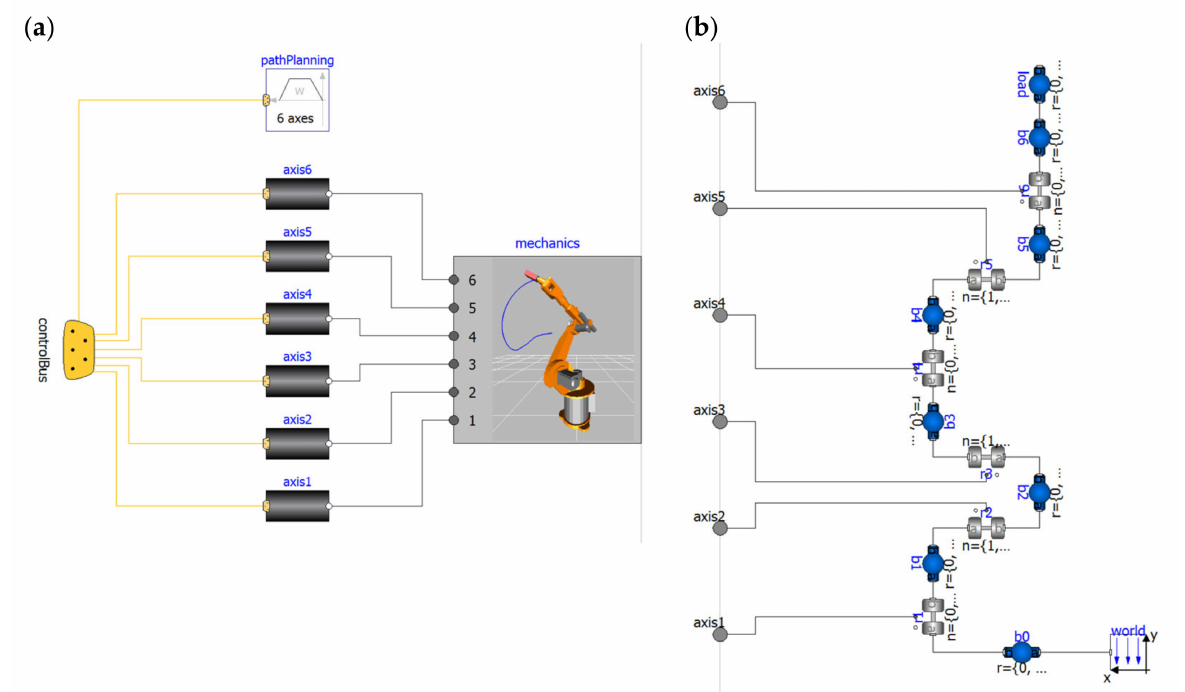
Figure 6. Sample model of industrial robot created using Modelica language and multibody library